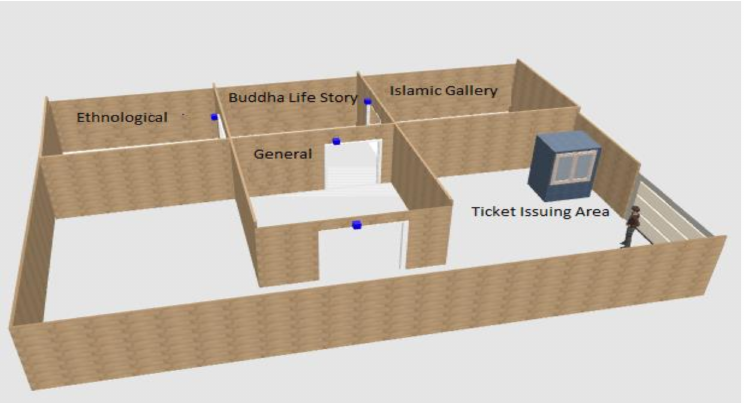
Figure 2. Three-dimensional map of Chakdara